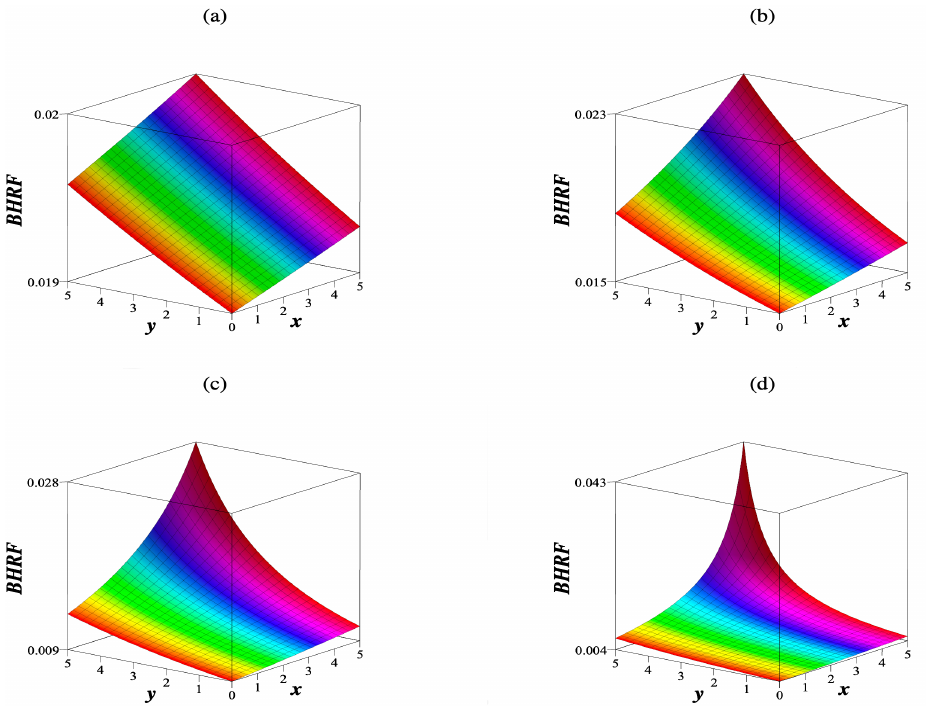
Figure 1. Bivariate hazard rate functions for ( λ 1 , λ 2 ) = ( 0.1,0.2 ) and different values of θ : ( a ) θ = 0.2, ( b ) θ = 0.5, ( c ) θ = 0.75 and ( d ) θ =